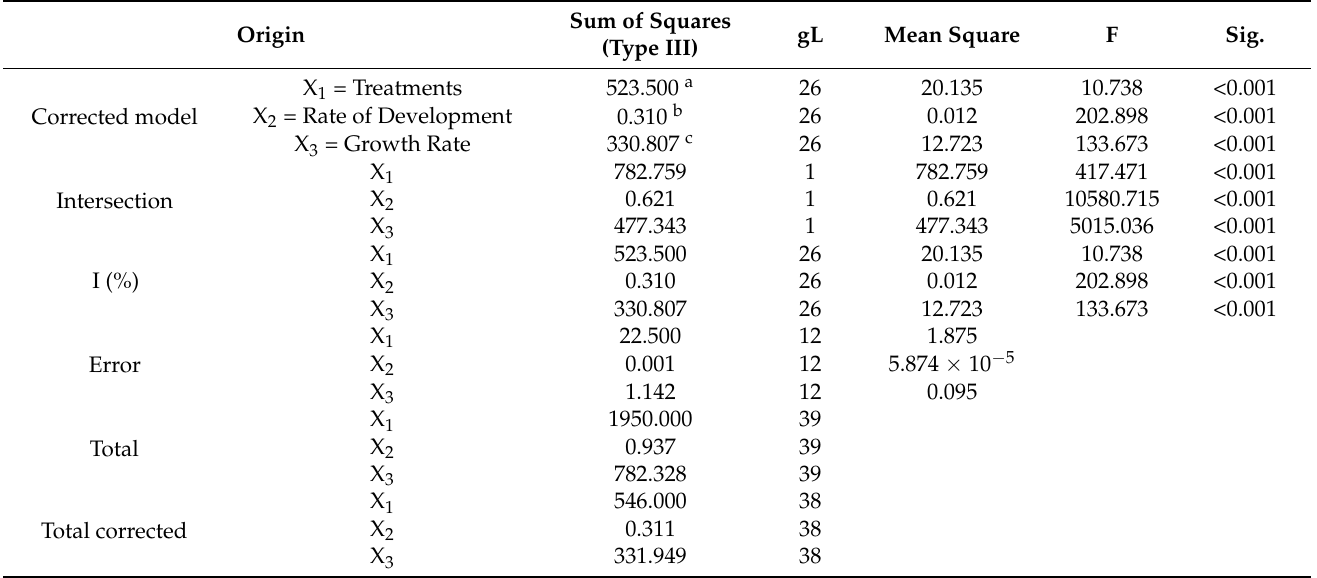
Table 5. Quadratic model of response surface for different concentrations of fungicides on rate of development, speed of growth, and percentage of inhibition of mycelial growth (I%) of the MA-FC120 strain in